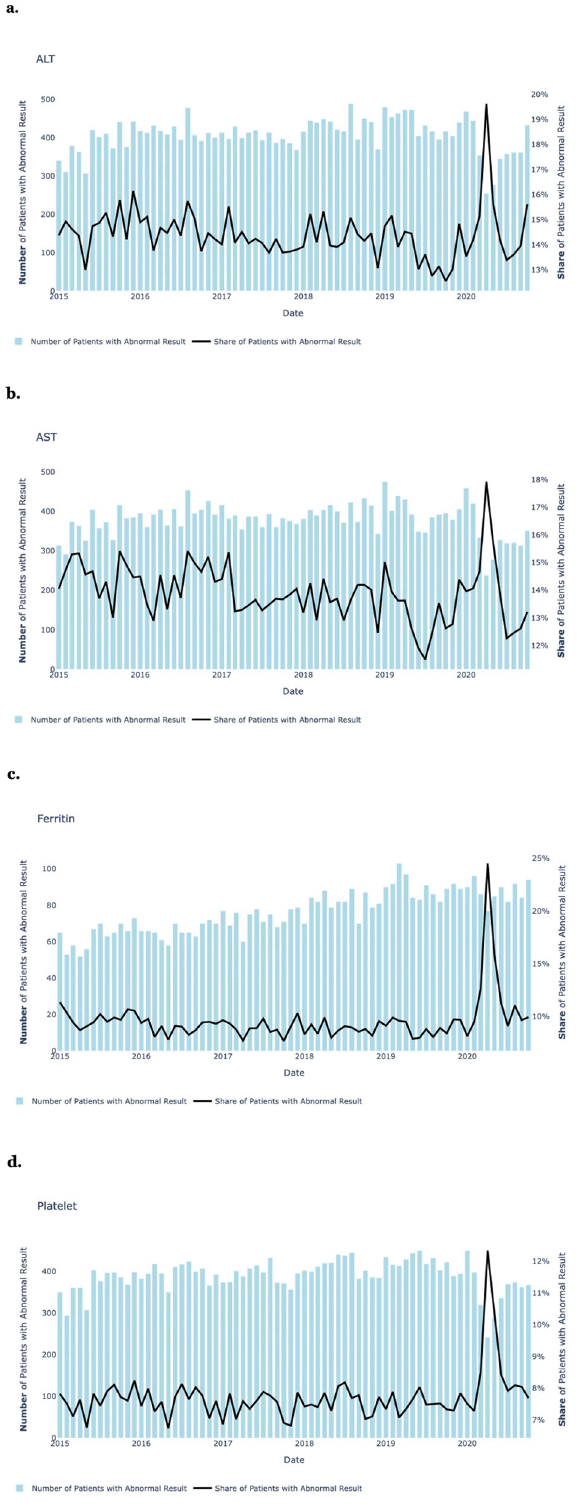
Fig. 2 Population approach, single laboratory tests. The total number of monthly abnormal test results (blue bars) and test abnormality rates (black line) recorded from January 2016 through August 2020, for selected single clinical laboratory tests: a ALT (alanine aminotransferase), b AST (aspartate aminotransferase), c ferritin, and d platelets.